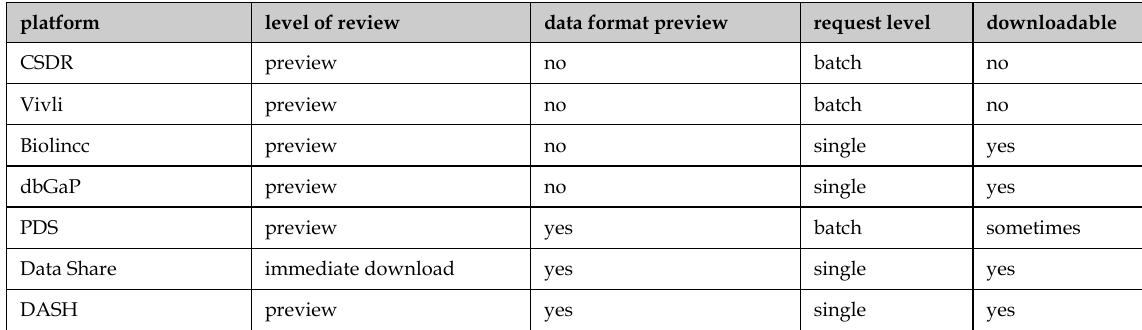
Table 1 Platform Dataset